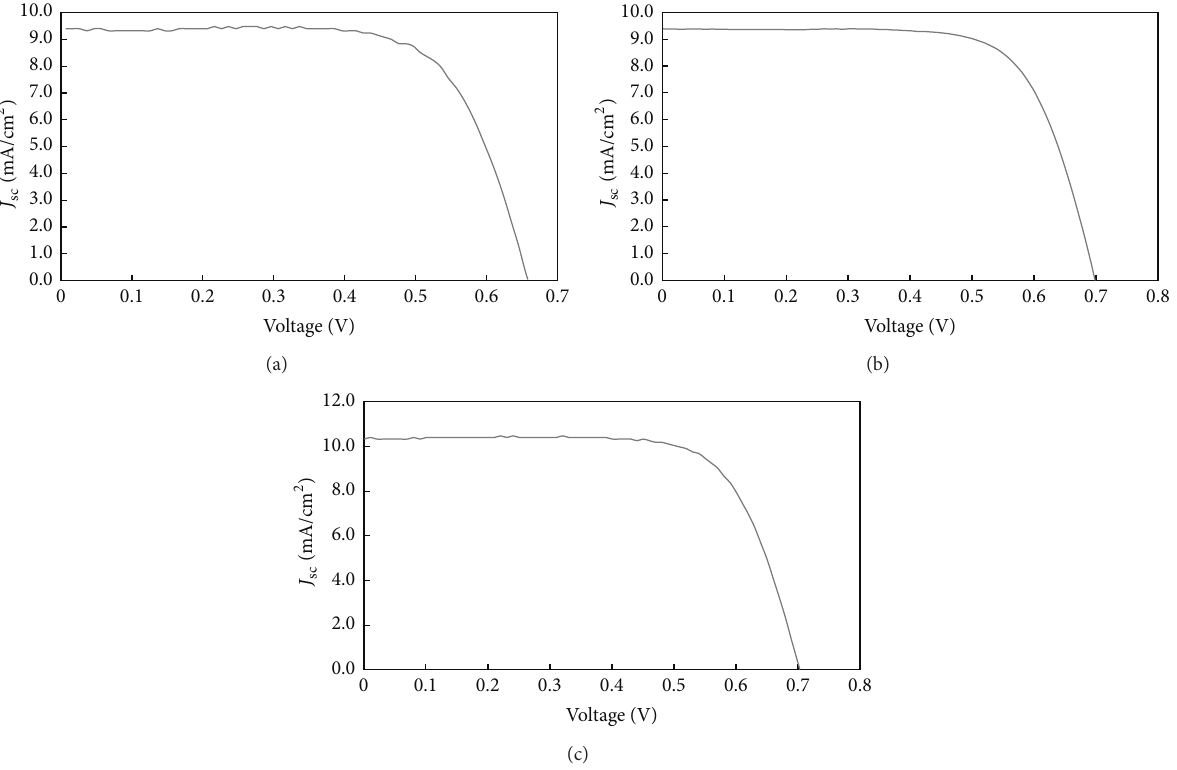
Figure 11: 𝐼 - 𝑉 curve efficiency for dye-sensitized solar cell annealed at (a) 550 ∘ C, (b) 650 ∘ C, and (c) 750 ∘ C.